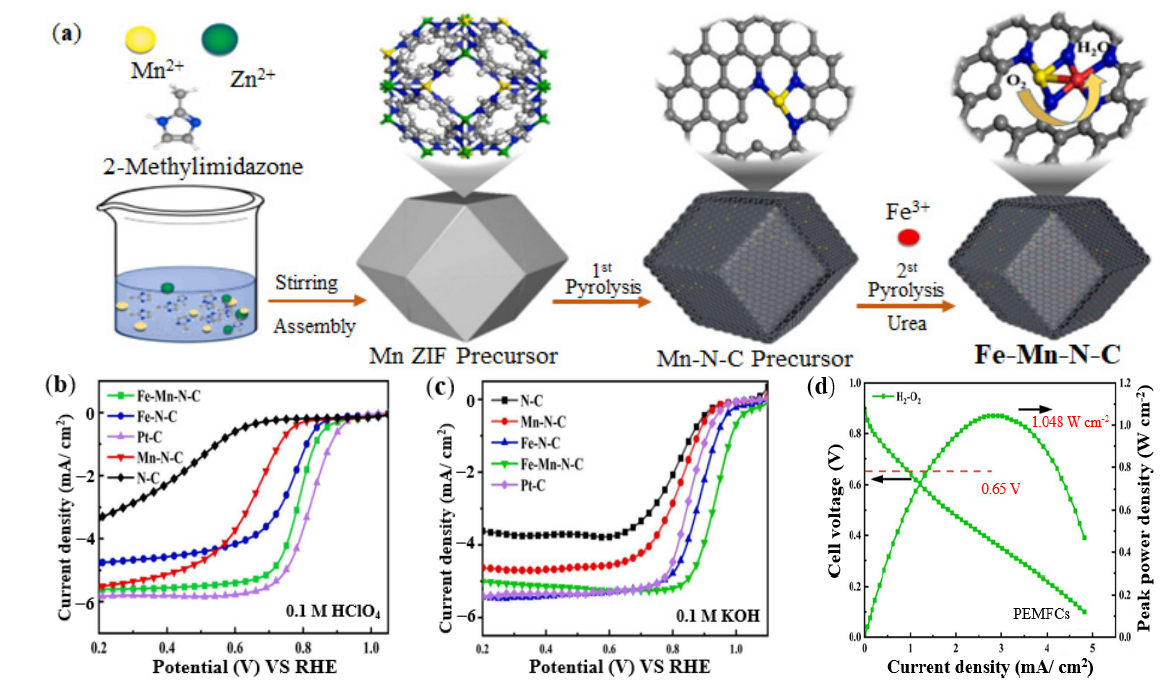
Figure 11. Synthesis method and performance of Fe-Mn-N-C catalyst: ( a ) Synthesis routes of Fe-Mn-N-C catalyst; ( b ) ORR activity in 0.1 M HClO 4 ; ( c ) ORR activity in 0.1 M KOH; ( d ) PEMFC performance. Adapted with permission from Ref. [129]. Copyright 2022 Elsevier.